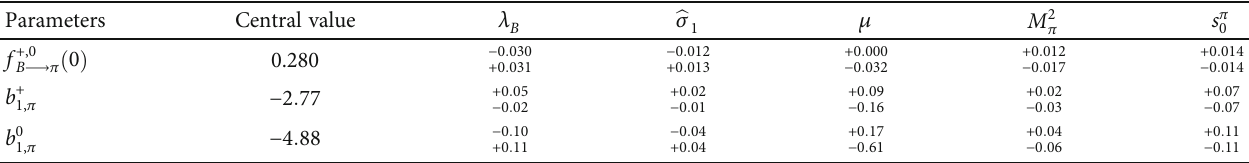
Table 3: Theory predictions for the form factors f +,0 uncertainties from variations of di ff erent input